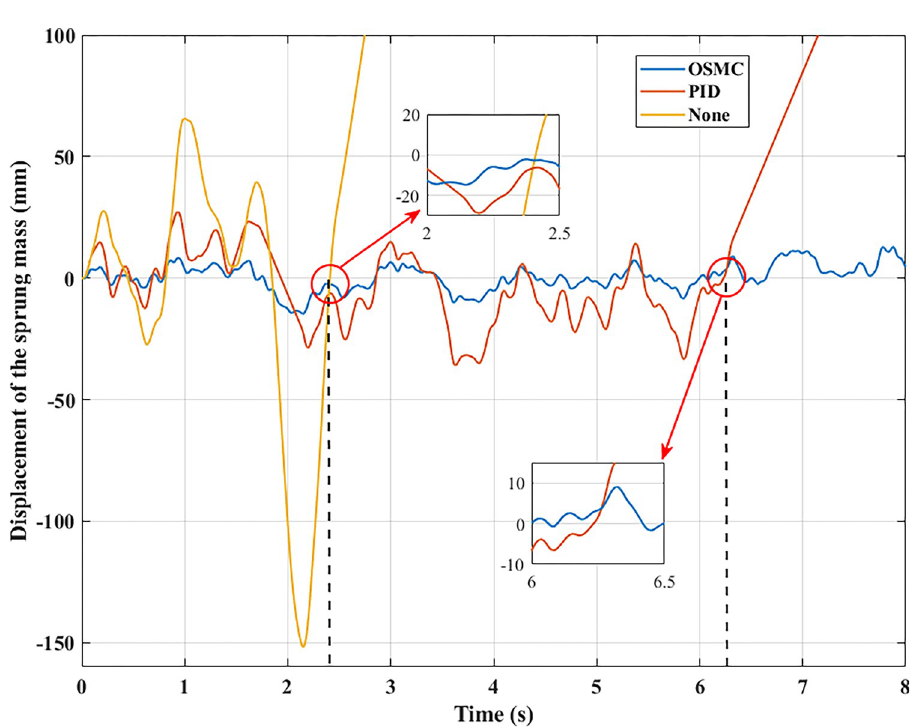
Fig 8. Displacement of the sprung mass (case